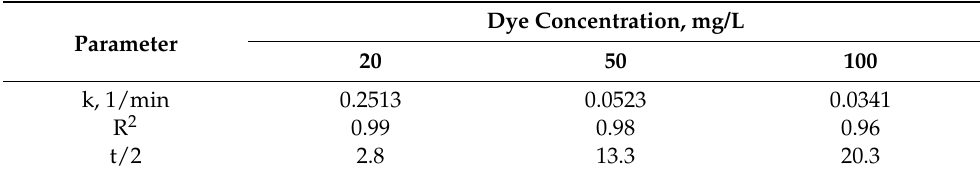
Table 3. Kinetic parameters of the combined advanced oxidation process (PDS/O 3 /UV) in a different dye concentrations.